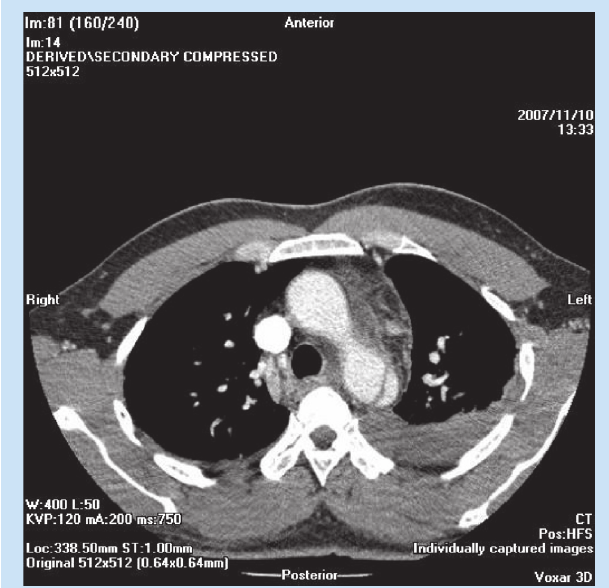
Fig. 1. Post-contrast chest CT angiogram (axial view), demonstrating a tear in the distal aortic arch associated with a left haemothorax.